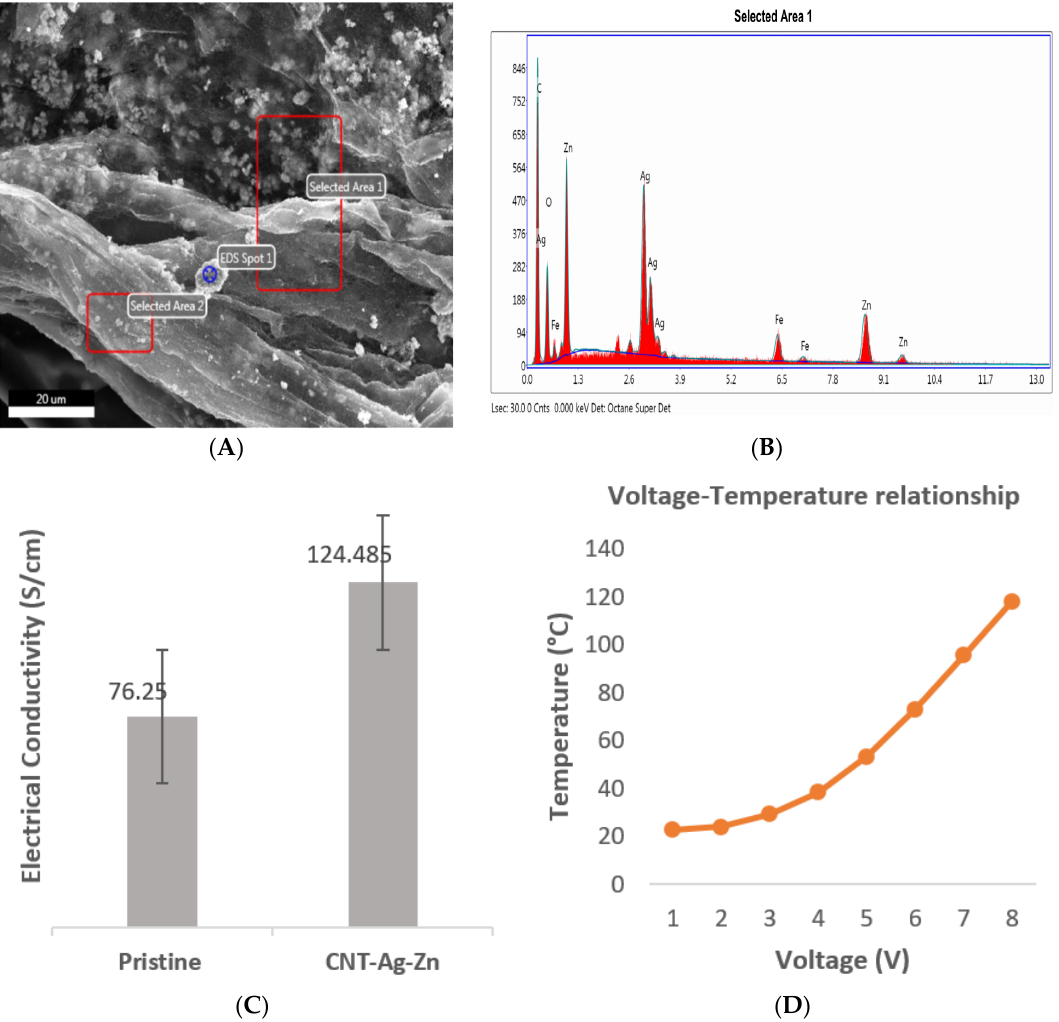
Figure 2. Properties of Carbon Nanotube Hybrid fabric. ( A ) microscopic image of the CNTH material-CNT-Ag-Zn; ( B ) EDX for CNTH material; ( C ) electrical conductivity of Pristine CNT and CNTH material-CNT-Ag-Zn; ( D ) voltage–temperature relationship of CNTH fabric material.